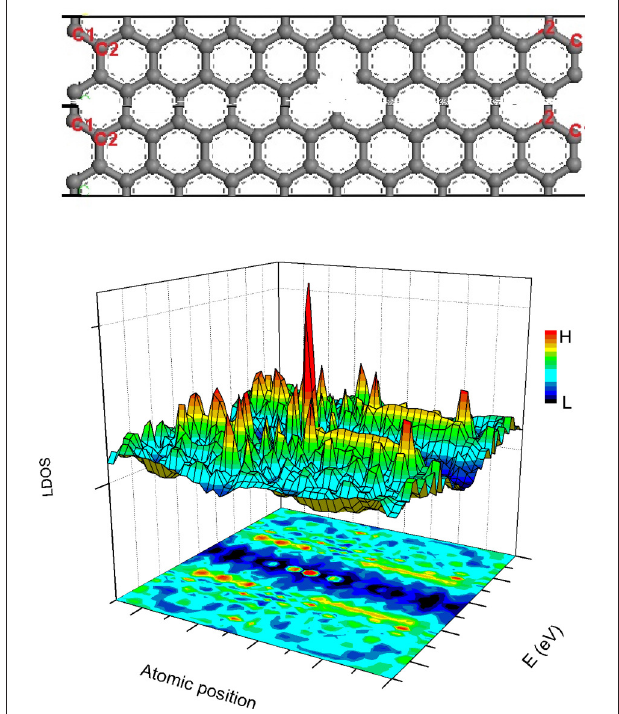
FIGURE 8 | The structure of vacAGNR-20 (up) and the BOLS-HM derived LDOS of the defective AGNR (down) . Reprinted with permission from Zhang et al. [90].